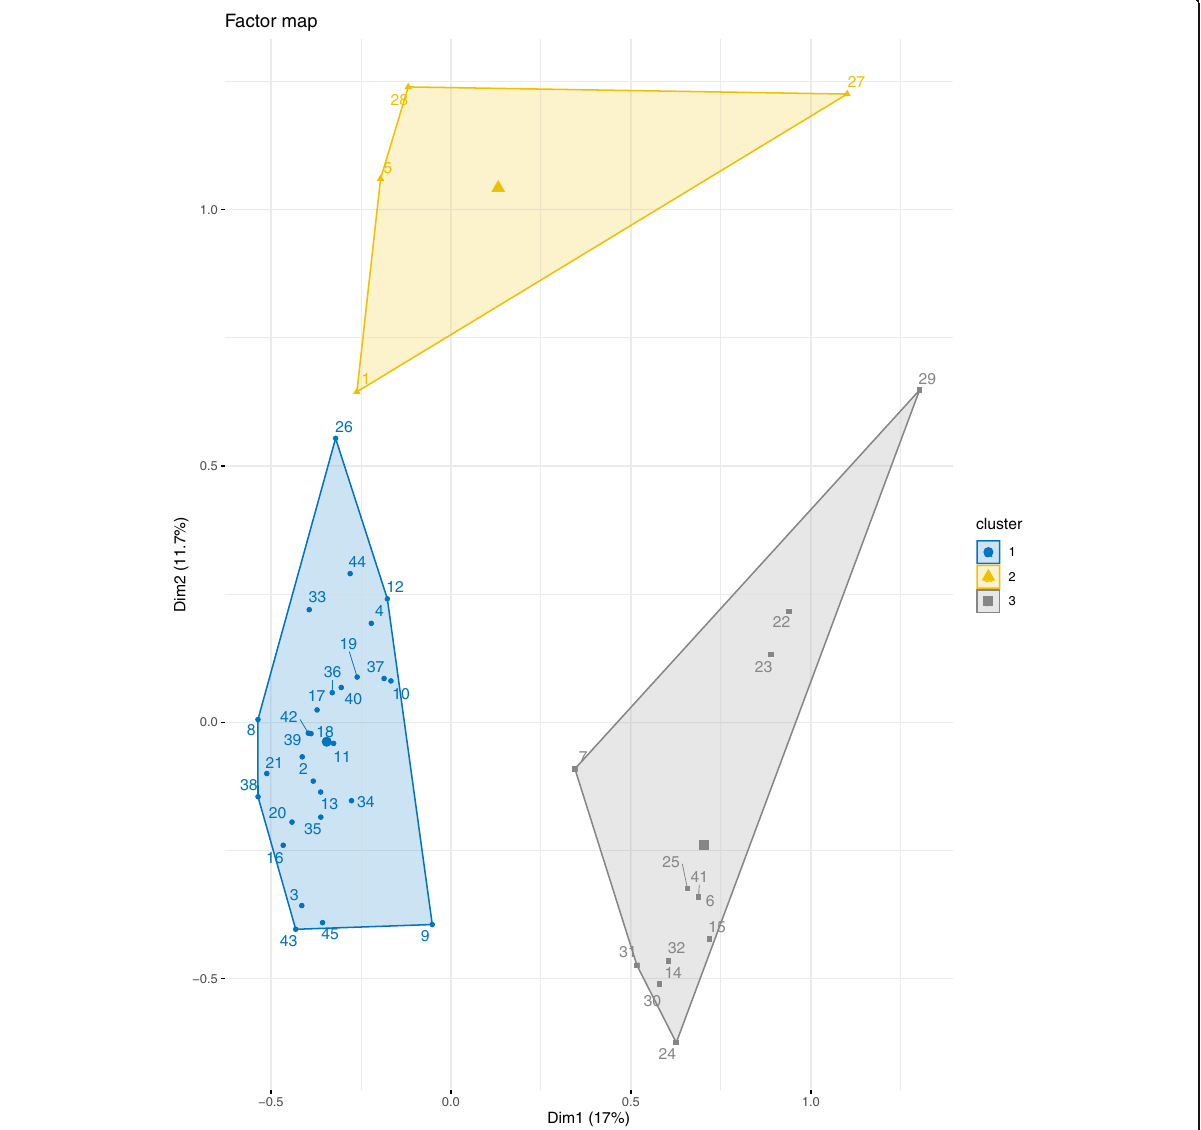
Fig. 4 Ascending hierarchical classification of the goat breeders applied to the typology of goat production systems in the Fatick region,